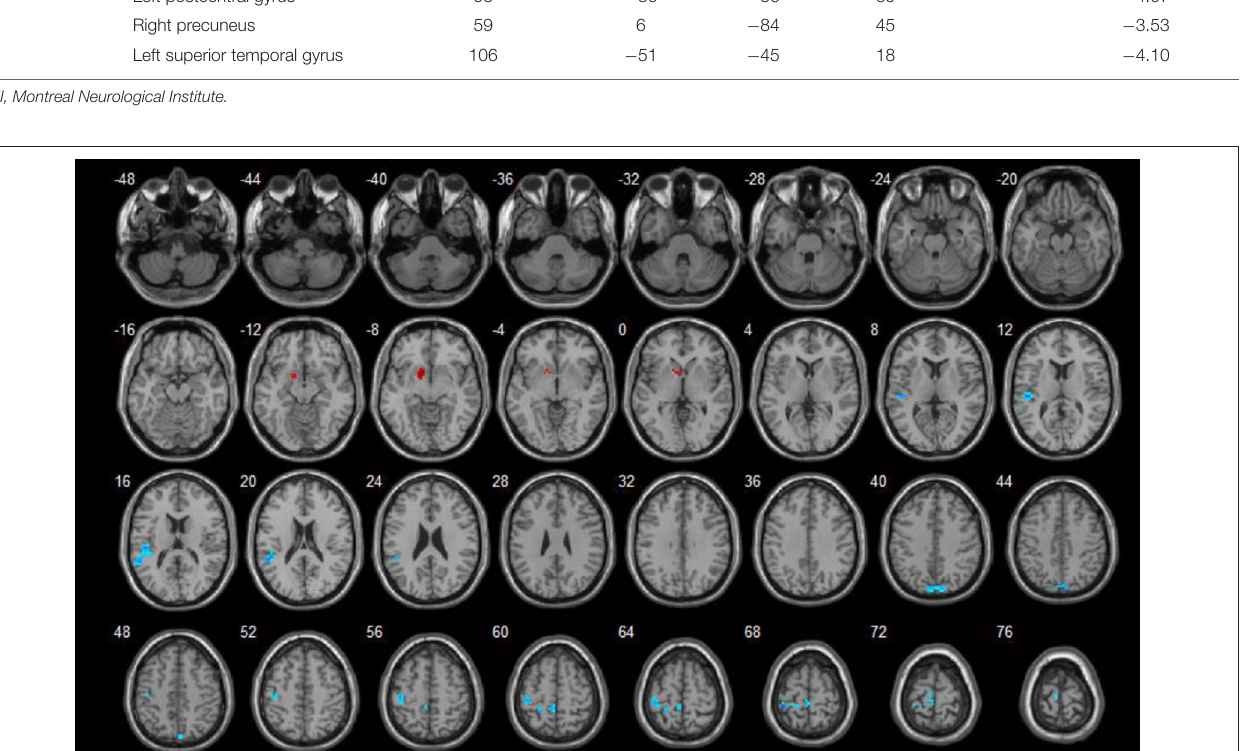
(29, 32). Nystedt et al. found hyperconnectivity of the thalamus in non-NPSLE patients, which might suggest a compensatory mechanism (